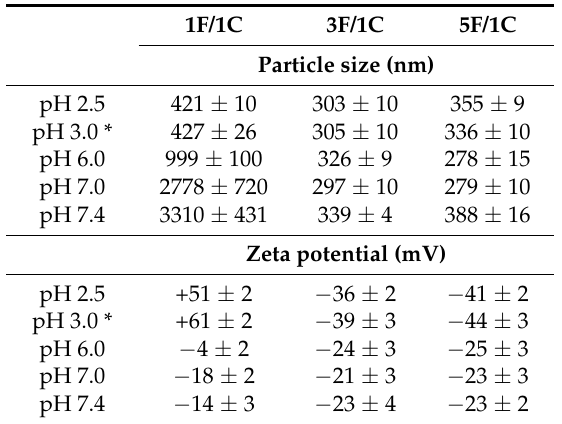
Table 1. Characterization of fucoidan/chitosan (F/C) nanoparticles under distinct pH conditions of the gastrointestinal